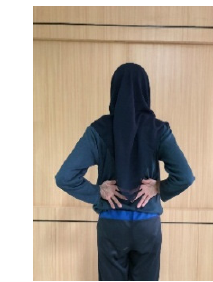
Figure 2. ( A ) The owl movement; ( B ) arm activation movement; ( C ) grounder movement; ( D ) gravity glider movement.